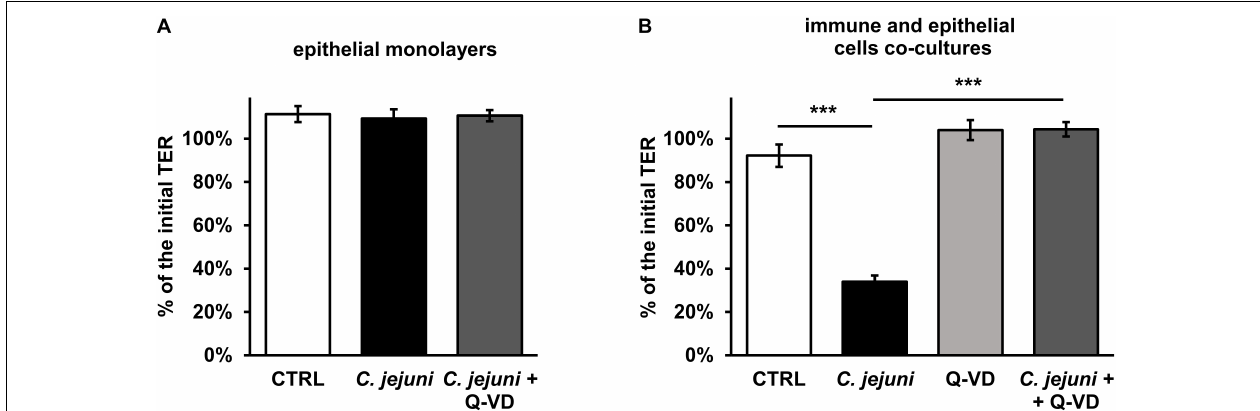
FIGURE 2 | Epithelial barrier function during the first day of Campylobacter jejuni infection in the epithelial mono-culture and co-culture. TER values were assessed 22 h after infection for (A) HT-29/B6-GR/MR intestinal epithelial cell mono-culture infected with C. jejuni (MOI 350) with or without a broad-spectrum caspase inhibitor Q-VD-OPh (10 µ M). n = 6. (B) The co-culture of HT-29/B6-GR/MR and THP-1 cells was infected with C. jejuni with or without the apoptosis inhibitor Q-VD-OPh. The TER values are presented as mean values ± SEM. n = 19–21, *** p < 0.001, unpaired Student’s t -test with Bonferroni-Holm correction for multiple